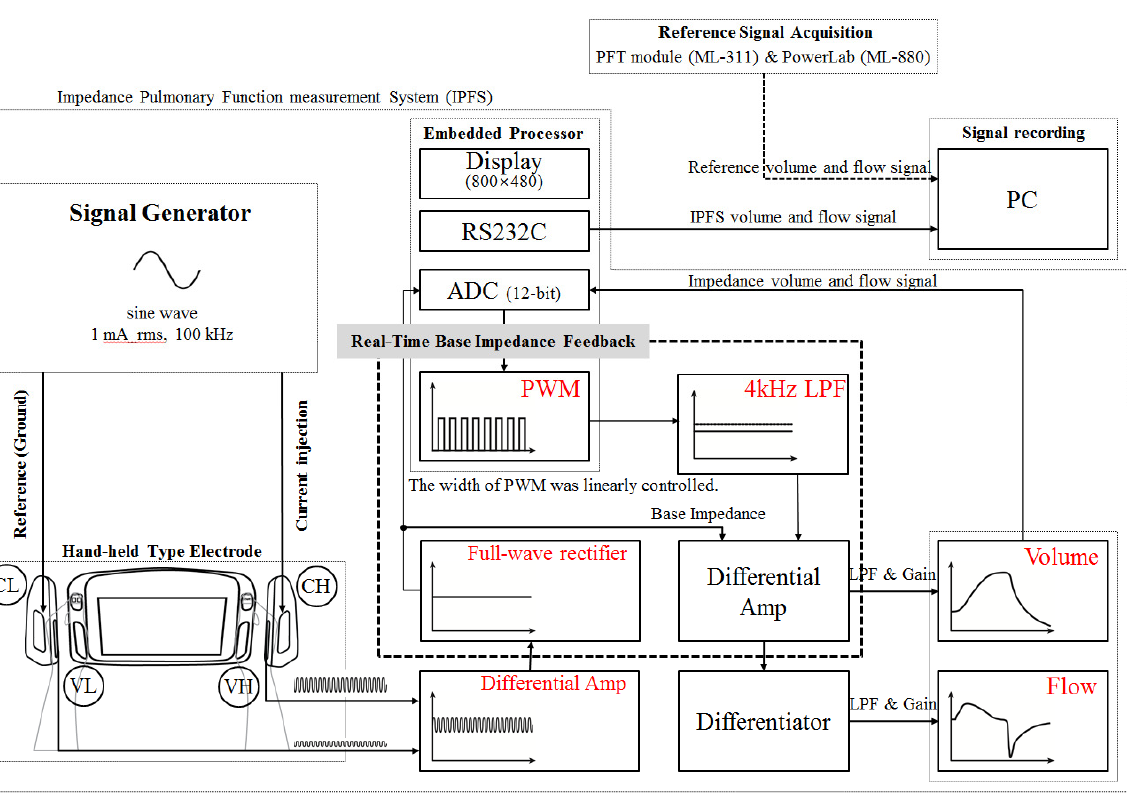
by electrodes VH (right hand) and VL (left hand) [20,21]. All electrodes are custom-made,